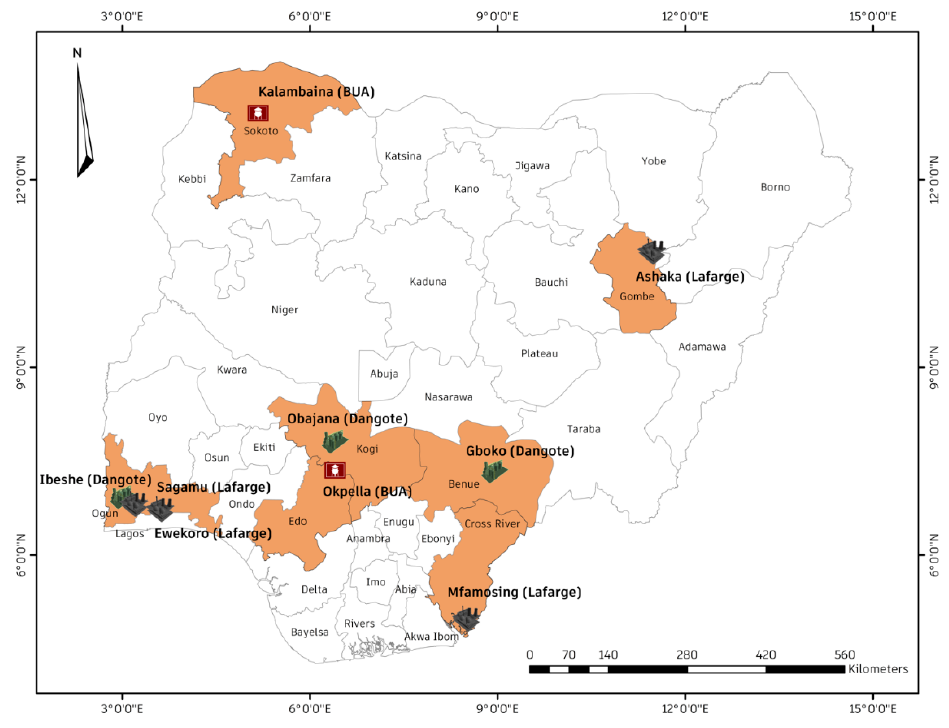
Figure 2. Major Cement Plants in